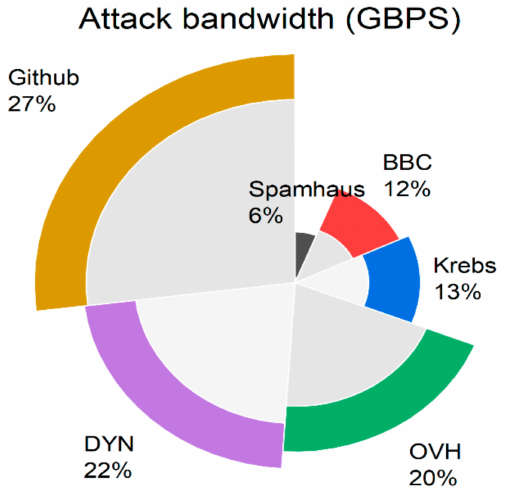
Figure 6. DDoS statistics in various IoT